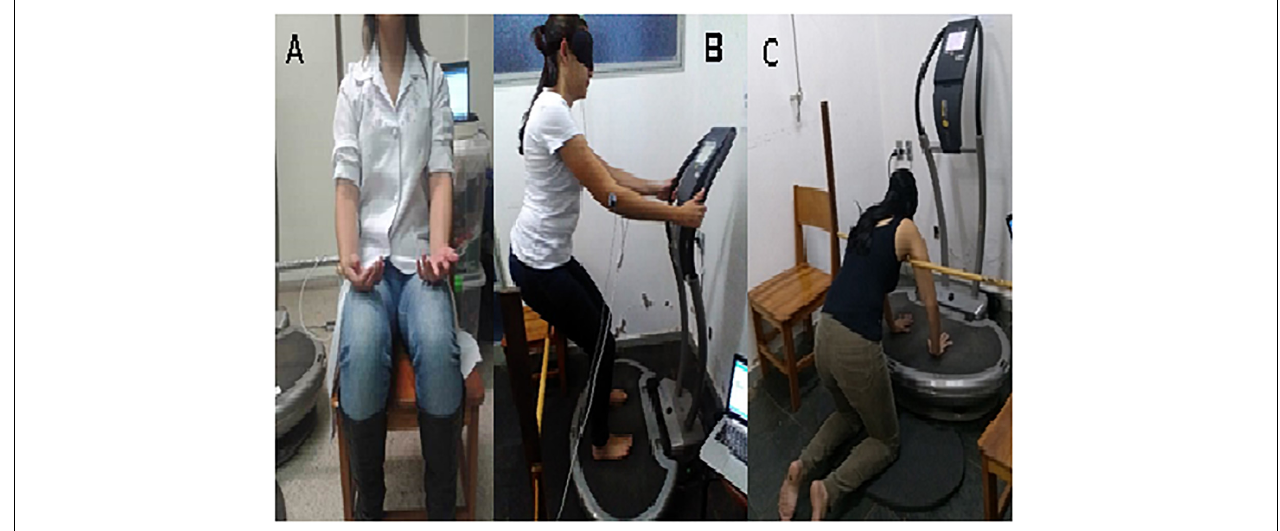
FIGURE 1 | Positioning during the experimental conditions. (A) Control, (B) Half-squat and Half-squat placebo, (C) Push-up modified and Push-up